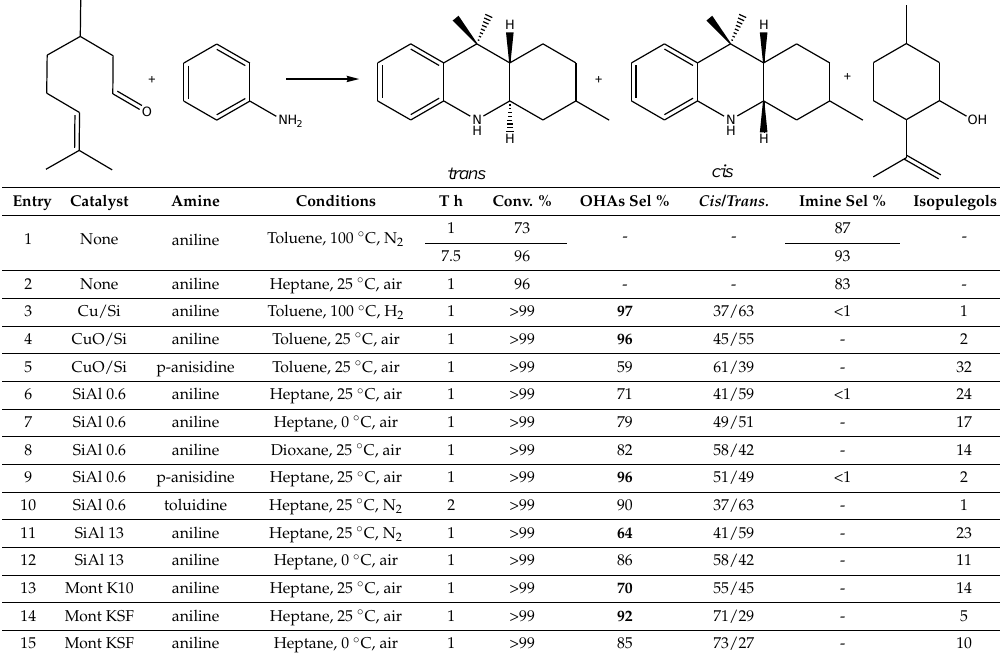
Table 1. Synthesis of octahydroacridines starting from ( ± )-Citronellal and anilines.